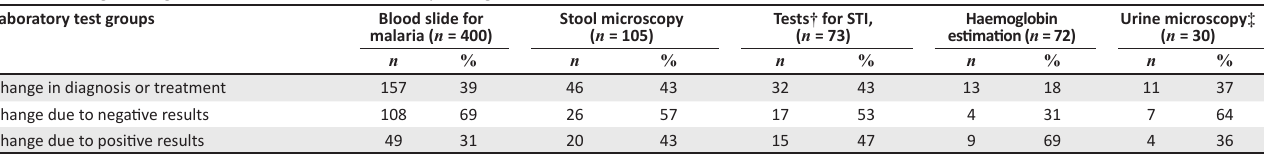
TABLE 3: Change in diagnosis or treatment after laboratory testing. Laboratory test groups